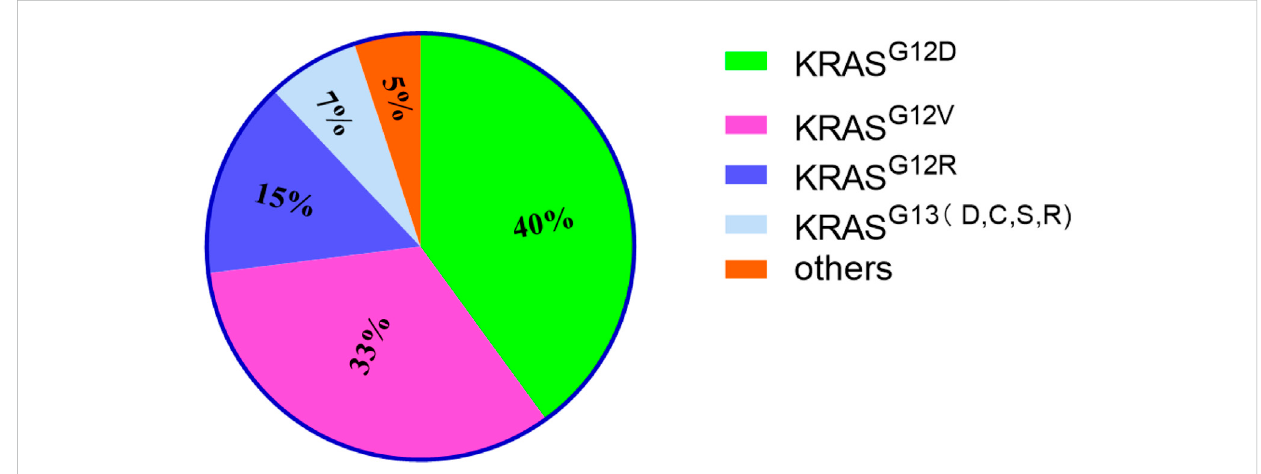
FIGURE 1 The proportion of KRAS mutations of different types. It mainly lists 4 types and others. Among them, KRAS G12D accounts for the highest